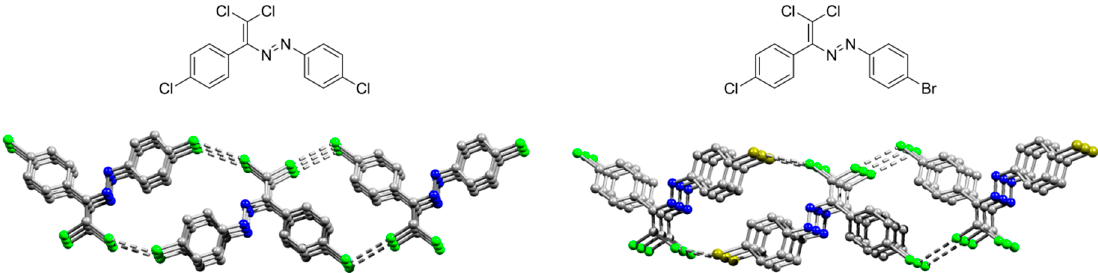
Figure 1. Ball-and-stick representation of 10 and its self-assembly via Cl ··· Cl bonding in the crystal. Blue, green and grey spheres represent nitrogen, chlorine, carbon atoms, respectively. Hydrogen atoms were omitted for clarity.